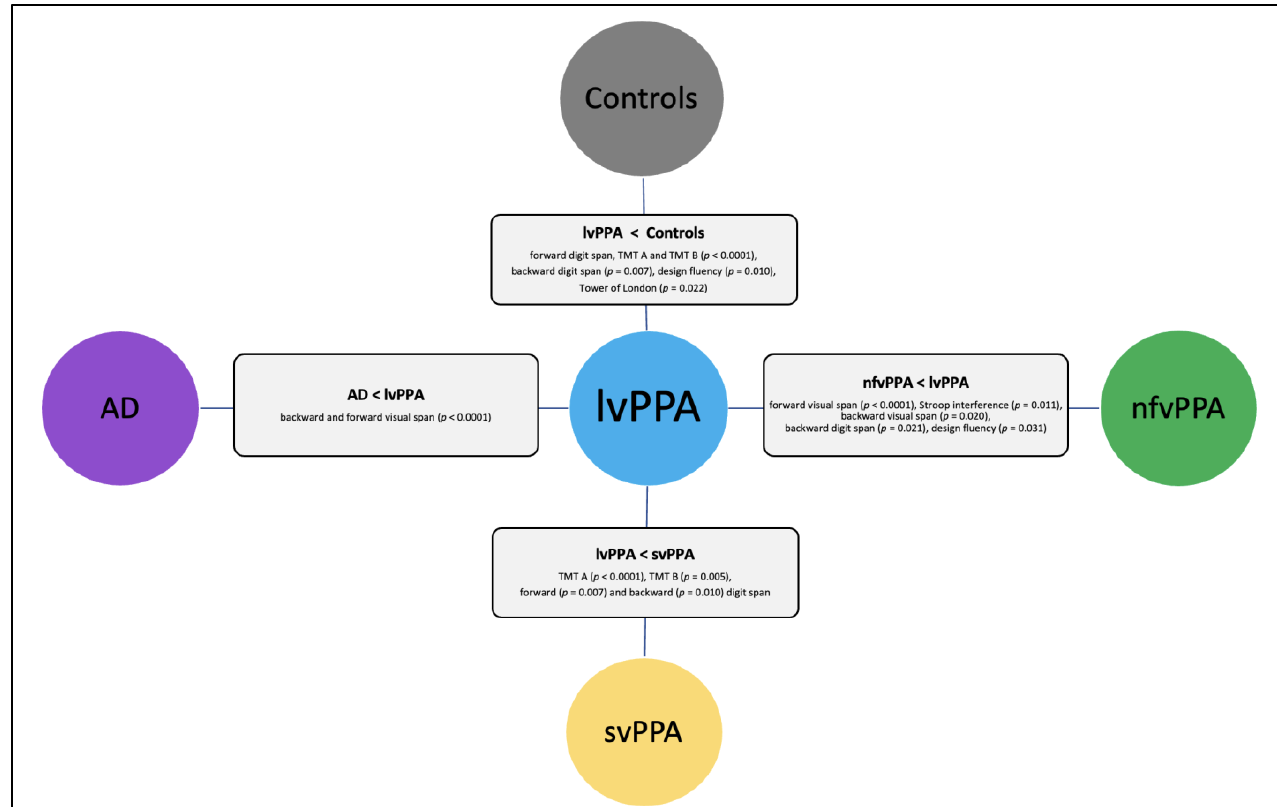
Figure 1. Executive tasks showing statistically significant differences between lvPPA and other clinical groups, inspired by Matias-Guiu et al. [36].